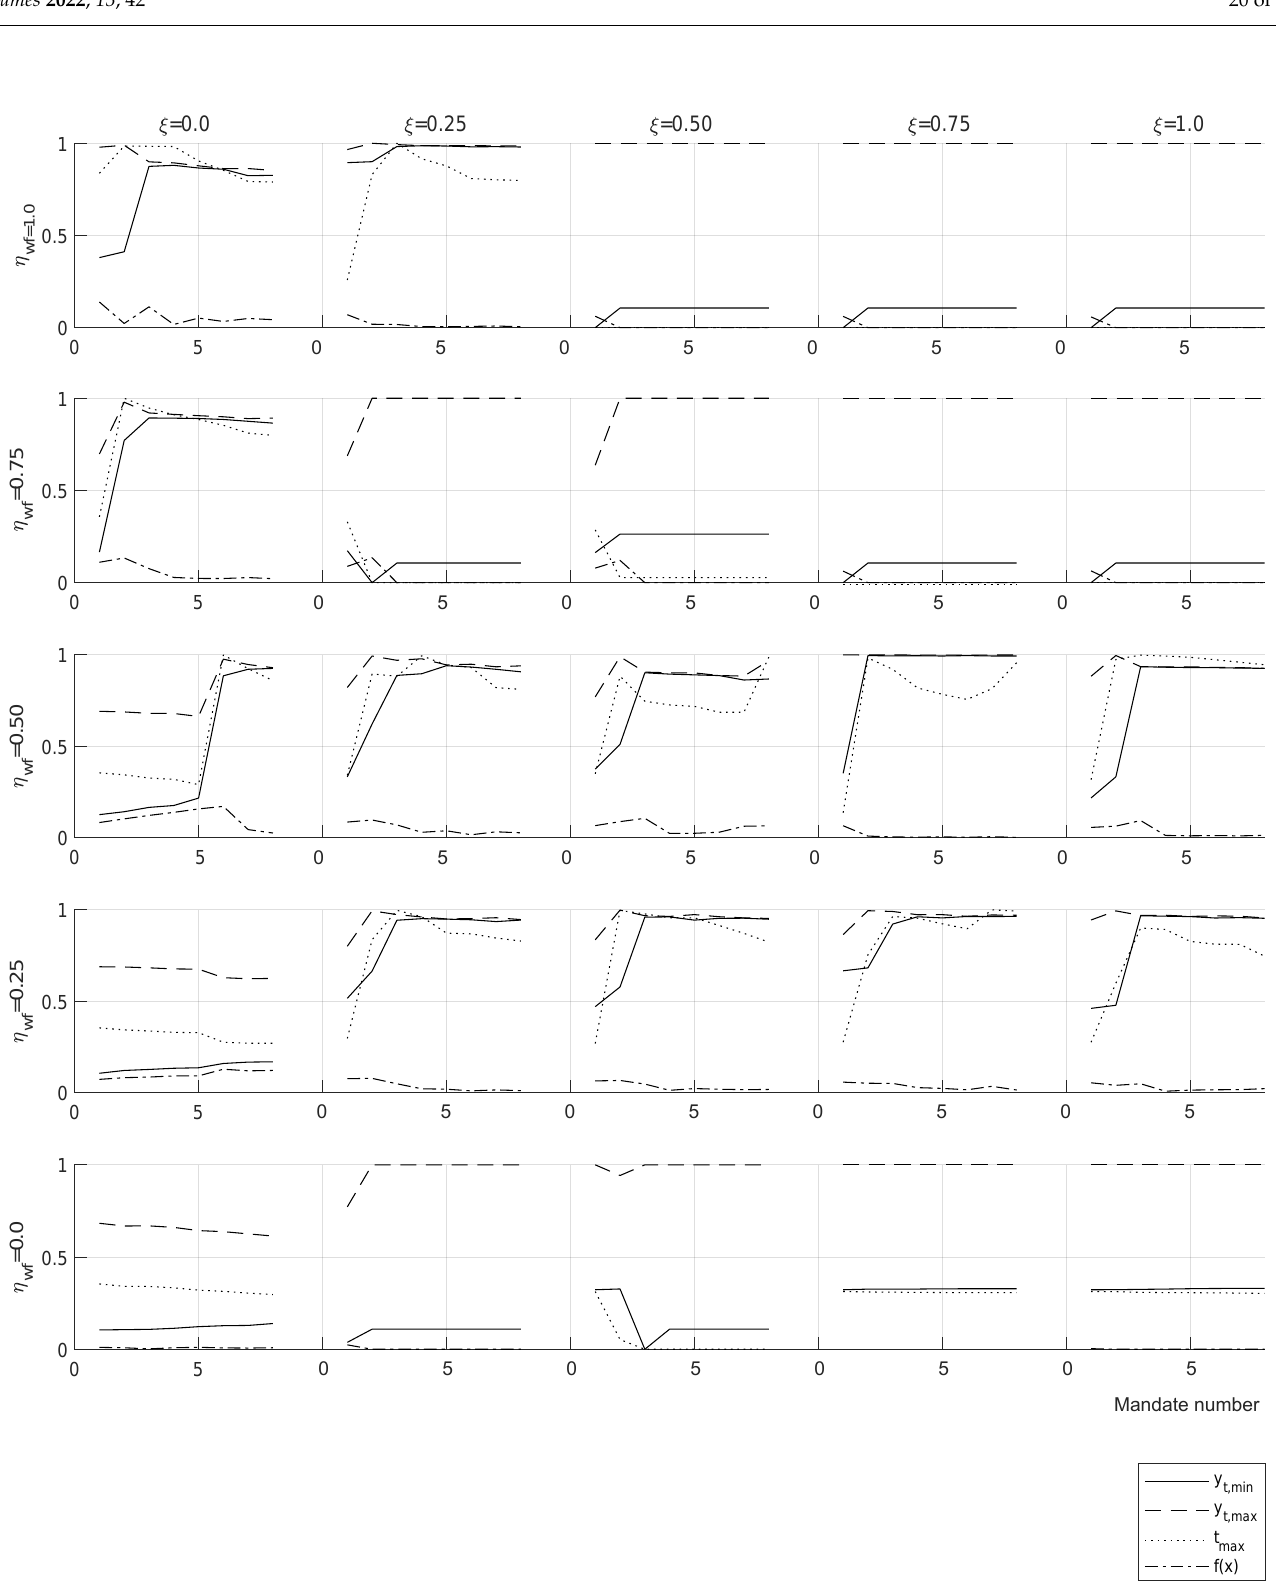
Figure A5. Tax policy evolution under yardstick vote during eight mandates for a series of welfare efficiency values η wf and tax disincentive ξ . Per citizen criterion. Mandate length: 4 years. Voters improvement demand